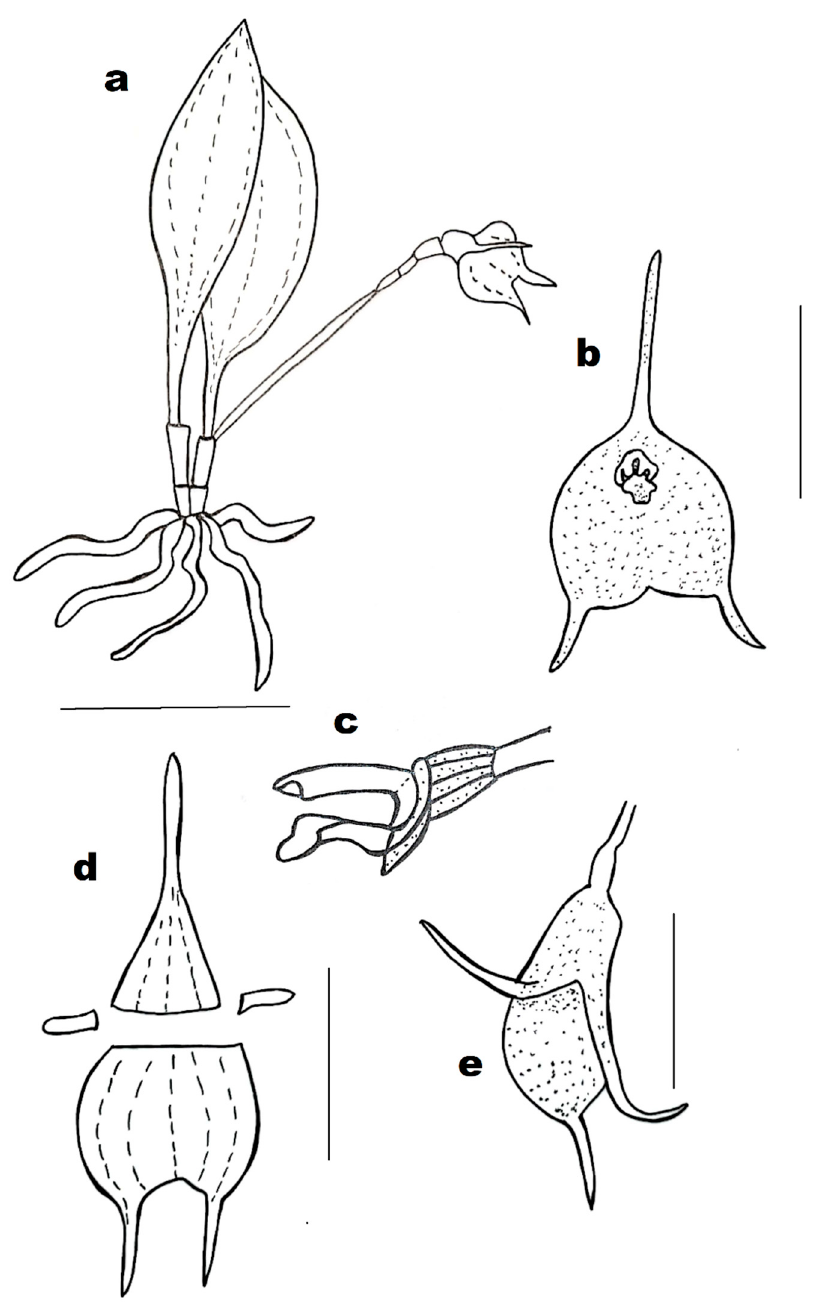
Figure 4. Masdevallia × urbanae : ( a ) habit; ( b ) front view of the flower; ( c ) side view on column and lip; ( d ) perianth parts; ( e ) side view of the flower (redrawn by Lipi´nska, scale bars: ( a ) 5 cm; ( b , d ) 1 cm; ( e ) 1 cm).